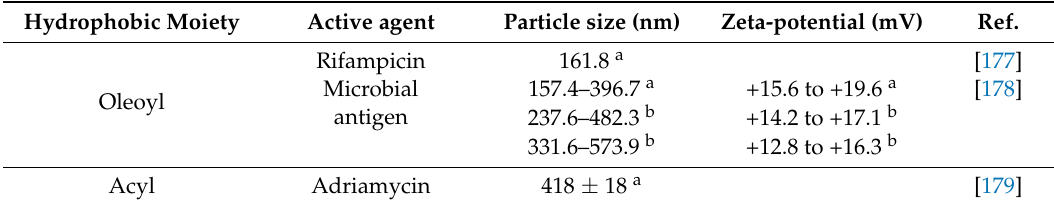
Table 6. Hydrophobically modified carboxymethyl chitosan.